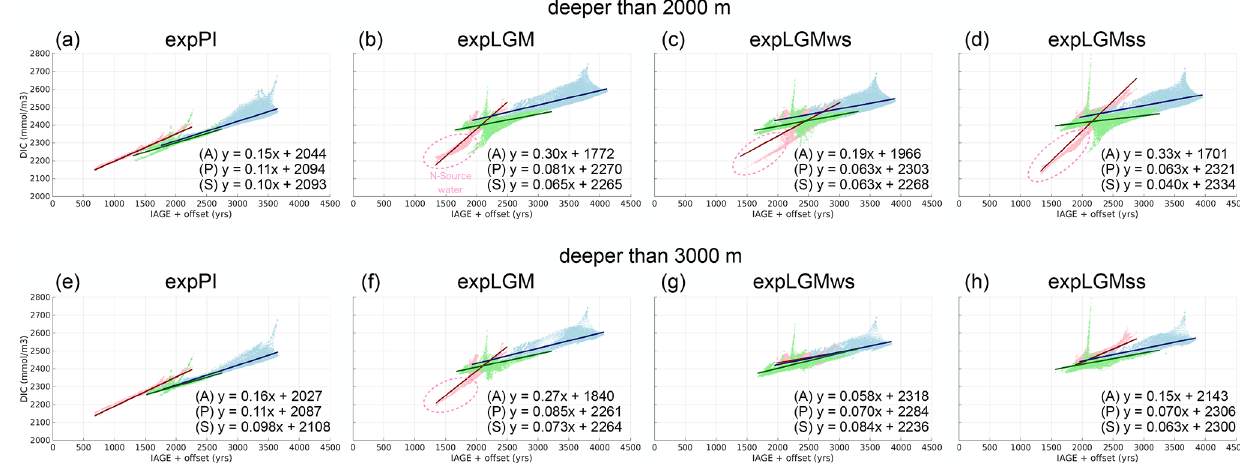
Figure 13. Scatter plots showing the correlations between DIC concentrations and the age of local water for the Atlantic (red), the Pacific (blue), and the Southern Ocean (green). The age was calculated by adding estimated reservoir ages for the surface water (Matsumoto, 2007; Skinner et al., 2017) to the modelled ideal age. The linear-regression coefficients are also shown at the lower right of each panel, where x denotes the simulated age (years) and y the concentration of DIC (mmolm − 3 ). The upper (lower) four panels show the properties of water that is deeper than 2000m